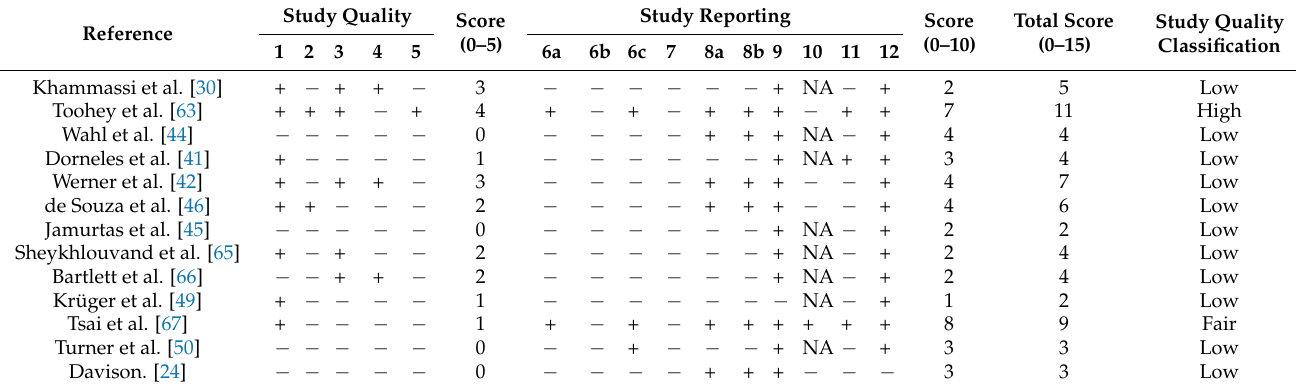
Table 3. Study quality and reporting of randomized clinical trial included